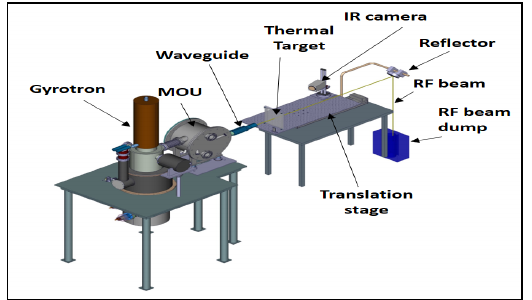
Fig. 21: Mode purity measurement scheme